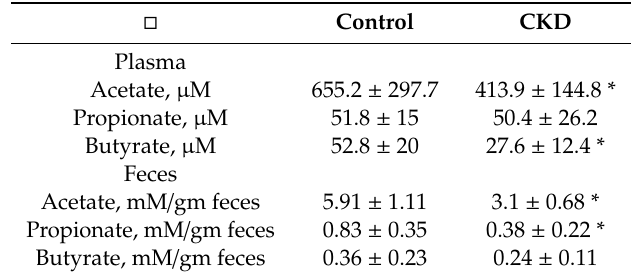
Table 2. Plasma and fecal levels of short chain fatty acids in mother